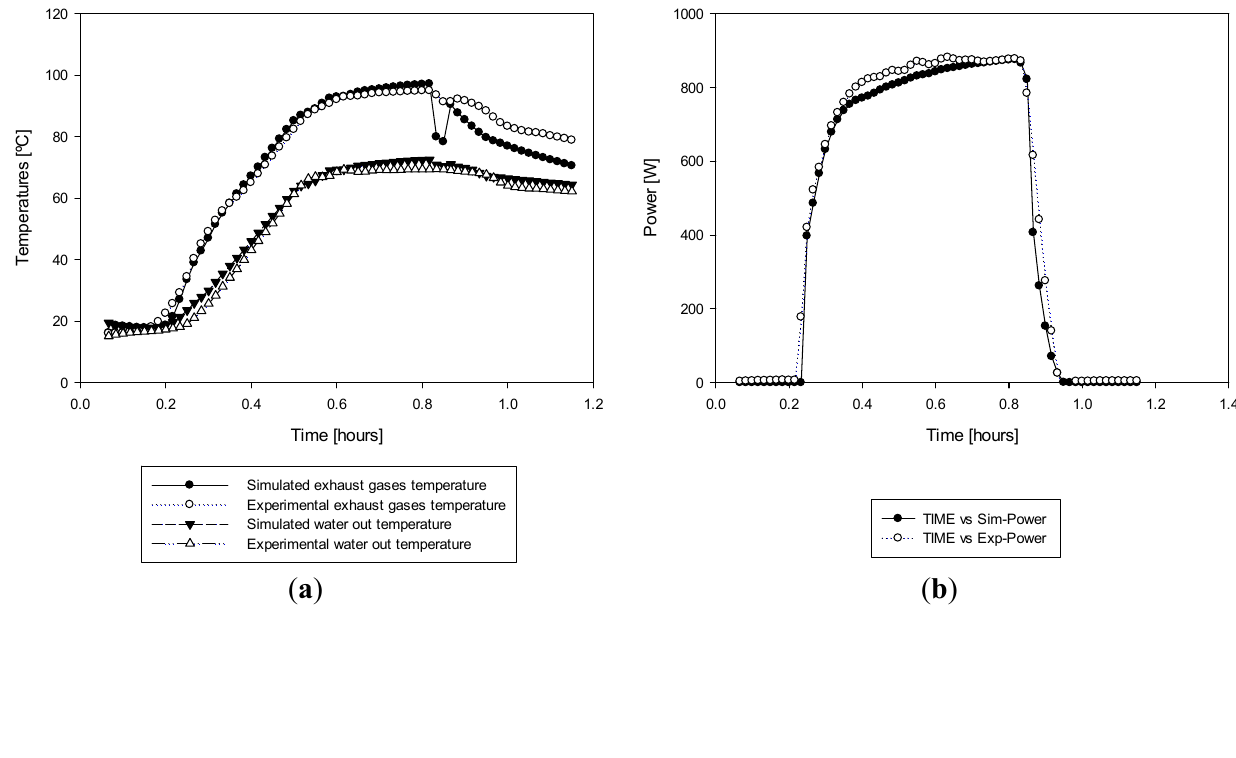
Figure 14. ( a ) Simulated and experimental outlet water temperature and exhaust gases temperature for T = 70 °C; ( b ) Simulated and experimental power for T set capacitance and heat transfer coefficient values are given in Table 1 (last